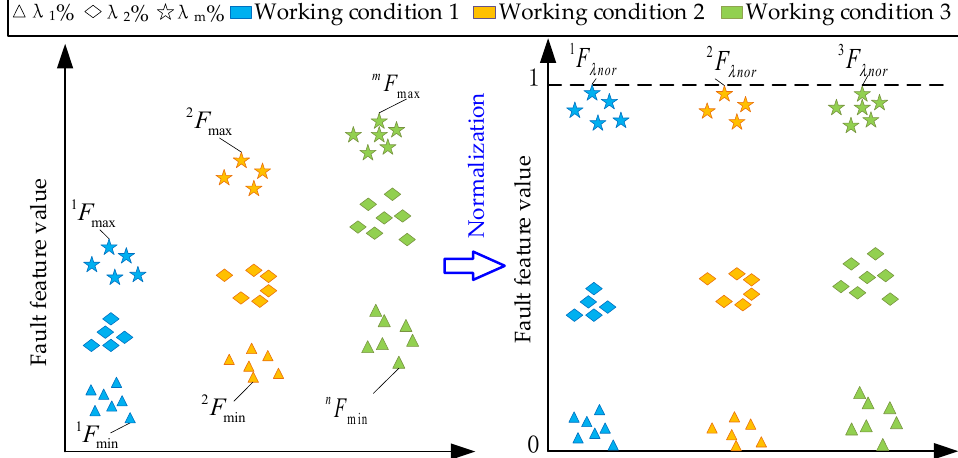
Figure 7. The schematic diagram of LSP.